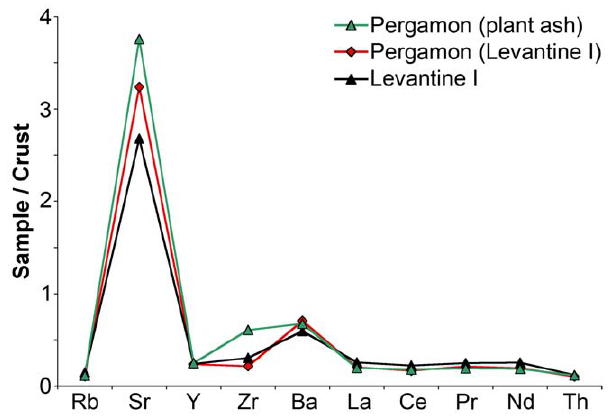
Figure 3. Trace element pattern of the plant ash glasses from Pergamon. Comparison of the average trace element distribution of the three plant ash glasses (shown in green) and the five Levantine I type fragments from Pergamon (red) with the mean of 9 Levantine I samples (black) from Apollonia [29]. The measured concentrations were normalised to the mean upper continental crust [43].